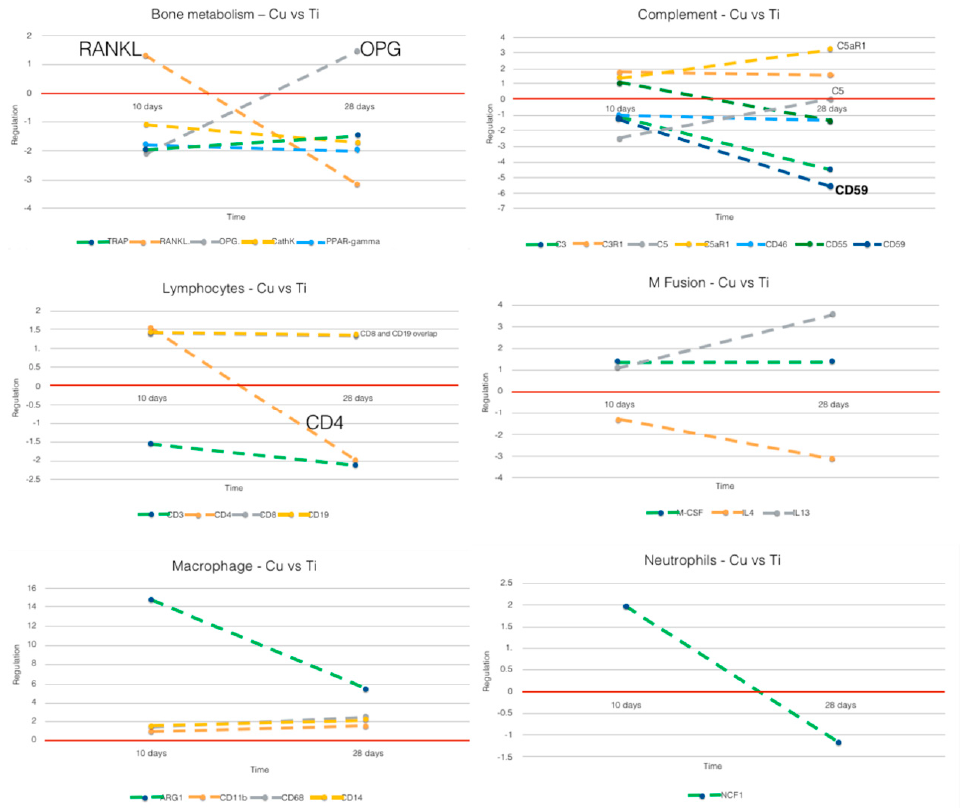
Figure 6. Comparative analysis of gene expression between 10 and 28 days for Cu vs. Ti. Horizontal red line: zero regulation mark; x-axis: time; y-axis: gene marker regulation (10 or 28 days). Intermittent lines do not represent actual results at time points other than 10 or 28 days, but only highlight trend from 10 to 28 days.